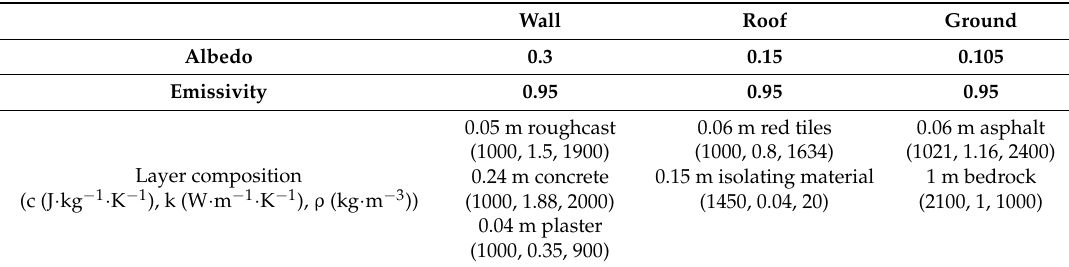
Figure 5. The different canyon configurations used to set and validate (cid:1844) (cid:3021)↓ estimation. Table 2. Materials properties used for each canyon configuration (specific heat (c, J ∙ kg − 1 ∙ K − 1 ), thermal